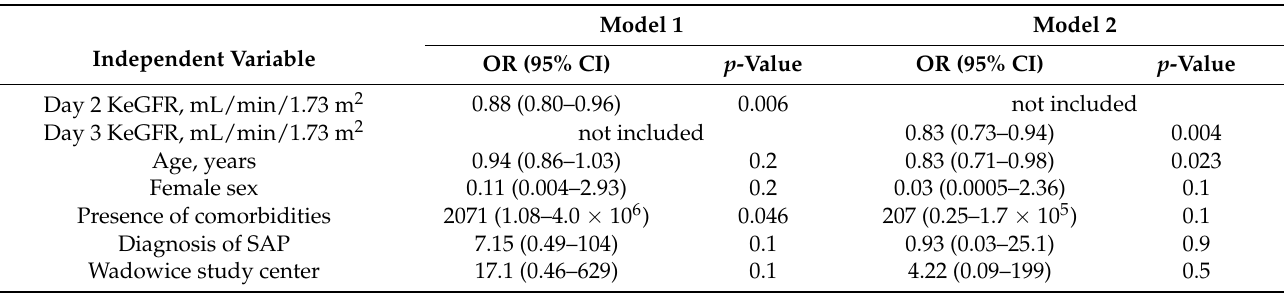
Table 5. Multiple logistic regression model to predict renal failure defined according to the modified Marshall scoring system. Adjusted odds ratios (OR) are reported per 1 unit increase in the value of independent variable.